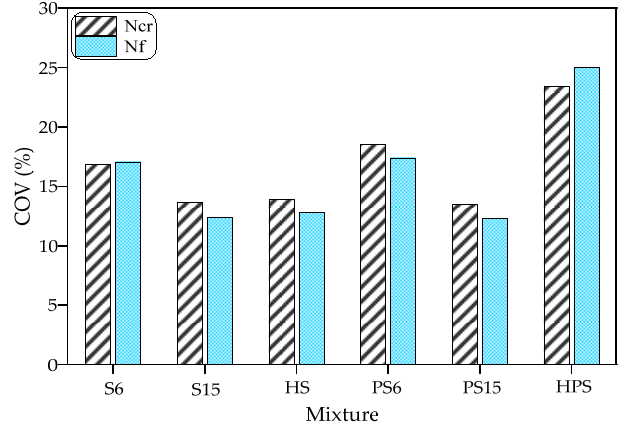
Figure 8. COV values of the repeated impact test